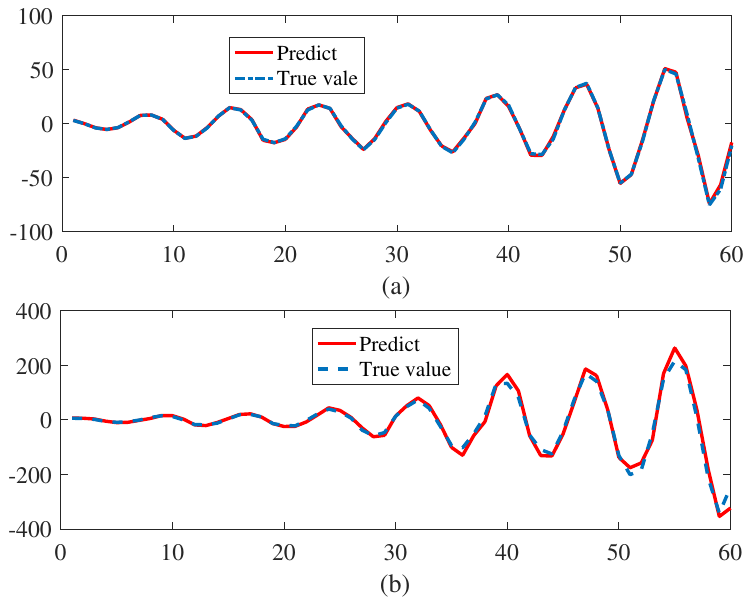
Figure 4. Output of the state model for 60 testing data in example 2: ( a ) ξ = 0.1 and ( b ) ξ = 0.3. 5.3. Example 3: Kernel State-Space Models (KSSM) for Autoregressive